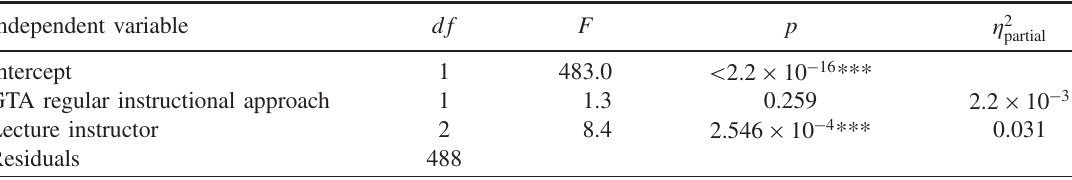
TABLE XV. Results of two-way ANOVA (type III) conducted on student performance on CSEM posttest in Physics II with GTA regular approach and lecture instructor as independent